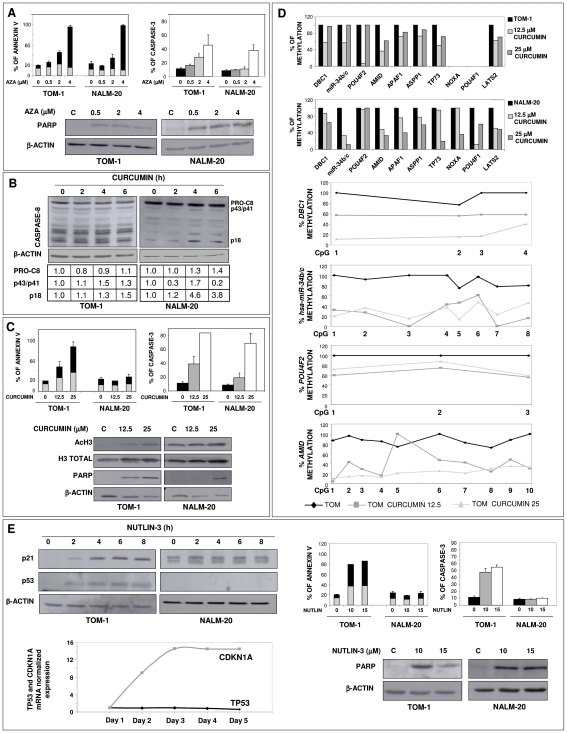
Activation of TP53 function induces cell apoptosis in ALL.TOM-1 and NALM-20 cells were treated with 5-aza-2-deoxycitidine, Curcumin and Nutlin-3. A. Apoptosis induced by 5-aza-2-deoxycitidine treatment: Annexin V analysis by flow citometry (grey: early apoptotic; black: late apoptotic/death cells), Caspase-3 analysis by flow citometry and Western blot analysis of the 85-kDa fragment of PARP. B–D. Curcumin treatment; Western blot analysis and quantification of Caspase 8. PRO-C8: full length caspase-8 fragment; p43/p41: cleaved intermediate p43/p41 fragment of caspase-8 and p18: caspase-8 active fragment p18. Numbers at the bottom of the figure represent the quantification of these three fragments of caspase-8 (B); Activation of apoptosis measure by Annexin V (grey: early apoptotic; black: late apoptotic/death cells) and Caspase-3 (FACS) and by the detection of the 85-kDa fragment of PARP (C). Upregulation in the amount of acetylated histone 3 by Western blot is shown. Total histone 3 and β-actin are loading controls (C); qRT-MSP and pyrosequencing of hypermethylated genes implicated in TP53 pathway before and after treatment with Curcumin (D). E. Western blot analysis of p21 and p53, levels of CDKN1A and TP53 mRNA by Q-RT-PCR and detection of apoptosis by Annexin V (grey: early apoptotic; black: late apoptotic/death cells), Caspase-3 and detection of the 85-kDa fragment of PARP by western blot after treatment with Nutlin-3. β-actin was used as a loading control in all cases. A,C and E, the mean ± SD of at least 3 different experiments is shown. A-E, a representative example of at least 3 different experiments is shown.